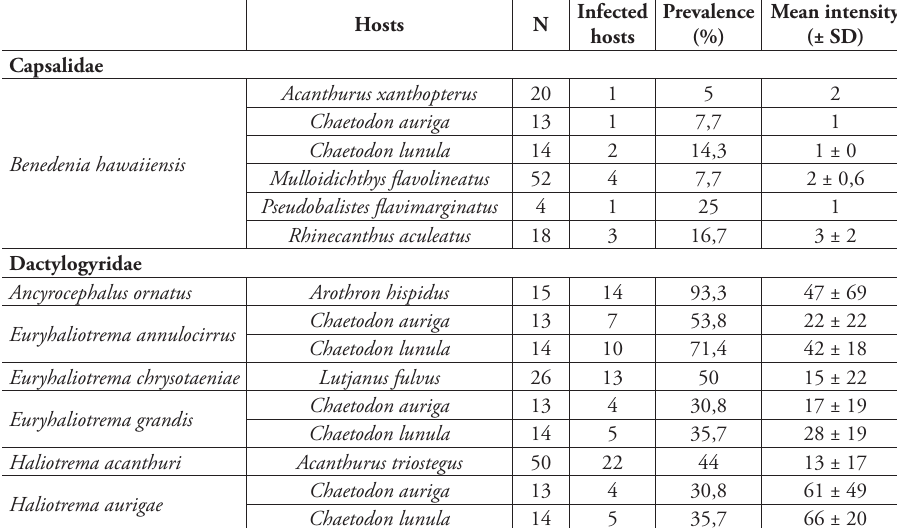
Table 2. Monogeneans of fishes from the lagoon flats of Palmyra Atoll; N = number of fish examined.